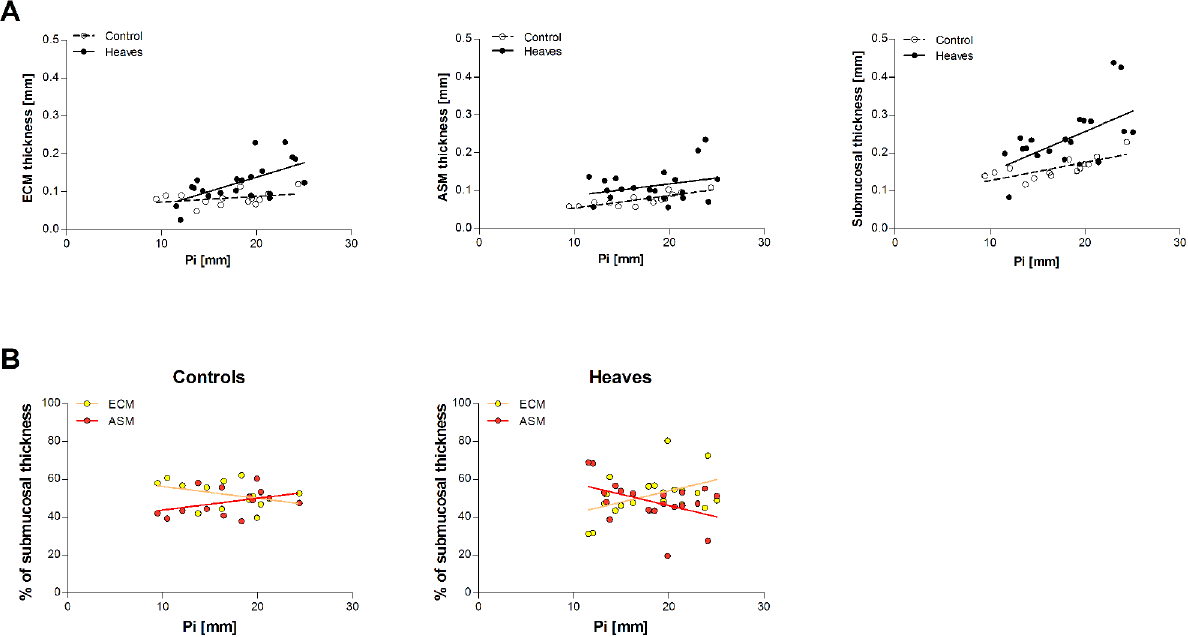
Fig 9. Composition of the submucosal tissues at histology. Values are presented as percentage of the submucosal tissue occupied by ECM and ASM for each airway. N = 14 for controls and 20 for heaves. On average, a greater percentage of submucosal thickness was occupied by ASM in smaller airways of horses with heaves compared to controls. This tendency reverses as the airway size increases. However, as the submucosal thickness is increased in horses with heaves compared to controls, the absolute thickness of the ASM layer still remains greater in horses with heaves than in controls for airways with Pi <